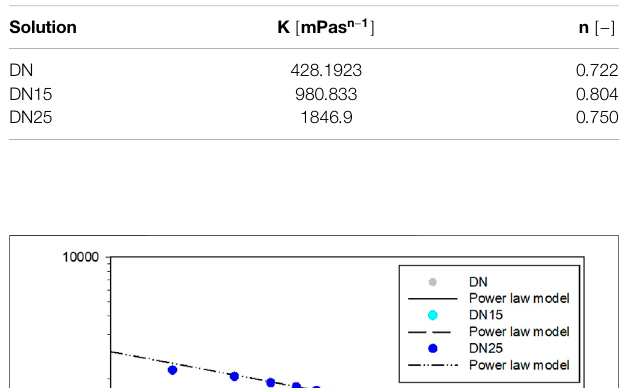
FIGURE 3 | In fl uence of the fl ow speed on the line